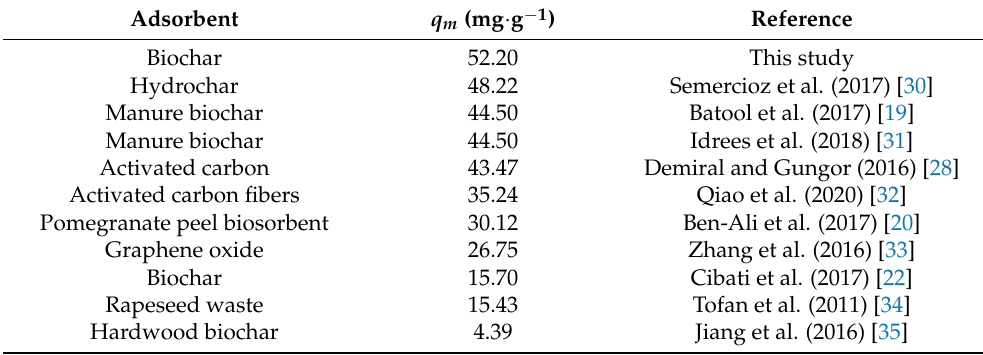
Table 7. Adsorption capacities of different adsorbents towards removal of copper(II) ions from aqua-solutions.